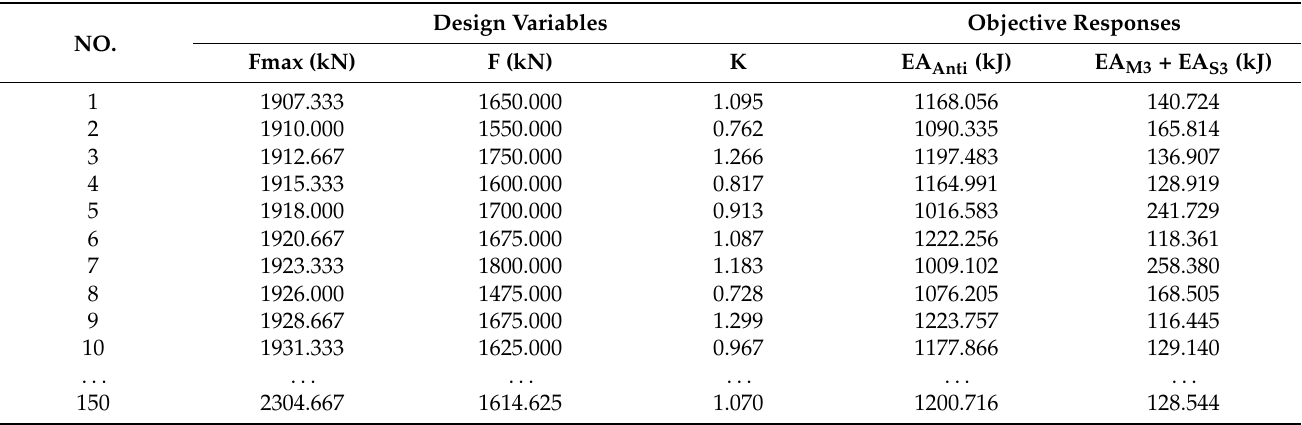
Table 3. Simulation